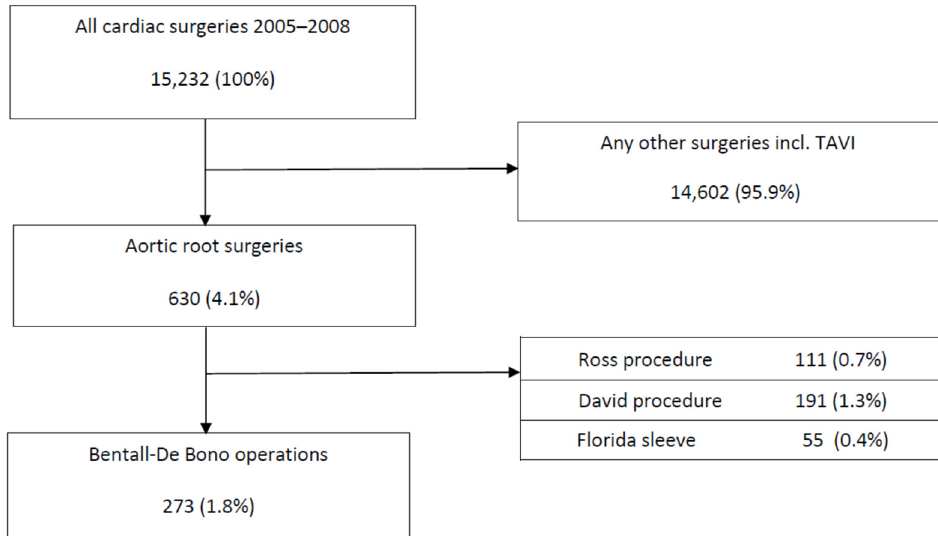
Figure 1. CONSORT-type diagram of patients with aortic valve and aortic pathology undergoing a Bentall–De Bono procedure. TAVI: transcatheter aortic valve implantation.